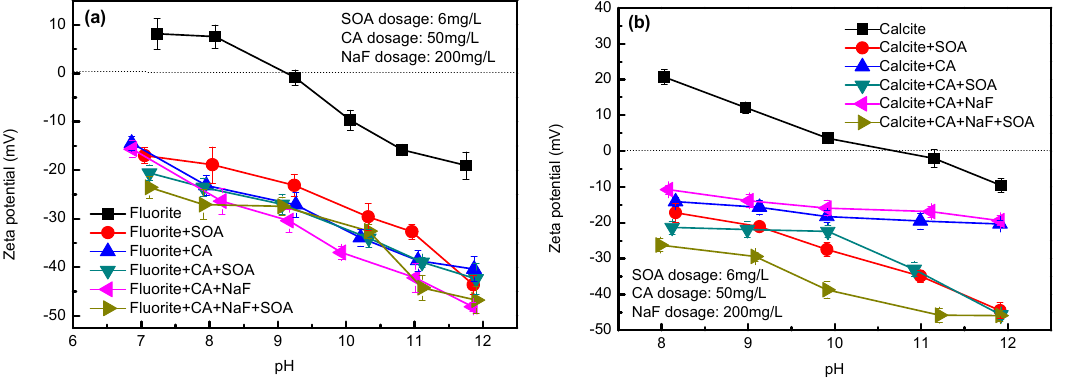
Figure 7. Zeta potentials of fluorite ( a ) and calcite ( b ) in the absence and presence of different reagents.